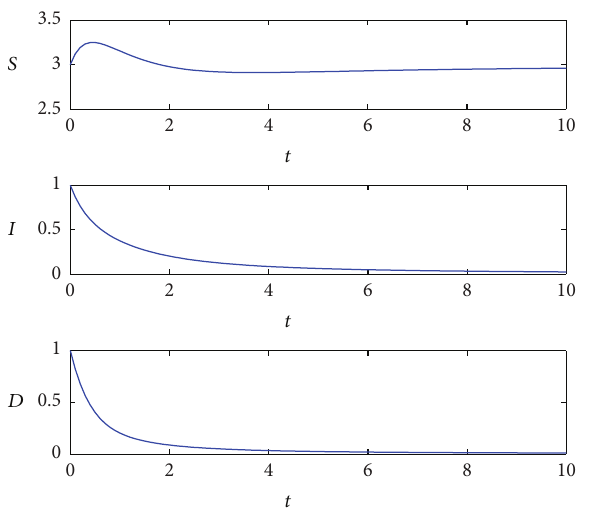
Figure 2: When 𝜏 = 0 , 𝑏 = 3 , 𝛼 = 𝑑 = 𝑘 = 𝑐 = 𝑢 1 = 1 , = 2 , and the initial value is (3,1, 1) , then 𝑅 𝑢 2 solution (𝑆(𝑡),𝐼(𝑡),𝐷(𝑡)) approaches to the disease-free equilibrium = (3,0, 0) as 𝑡 → ∞ . 𝐸 0